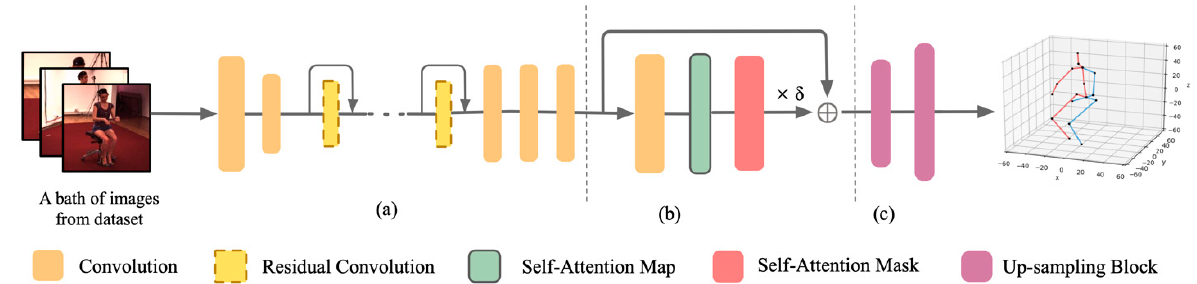
Figure 1. Framework: Illustration of the proposed approach. The basic structure contains three parts. ( a ) ResNet backbone which is used to extract features from images. ( b ) Self-Attention Network (SAN), which learns long-range dependency to compensate the lost features from original images and reweight obtained feature maps. With increasing δ , the model will depend more on nonlocal information than local content. ( c ) An upsampling block to regress the feature maps to higher resolutions to refine joint locations.